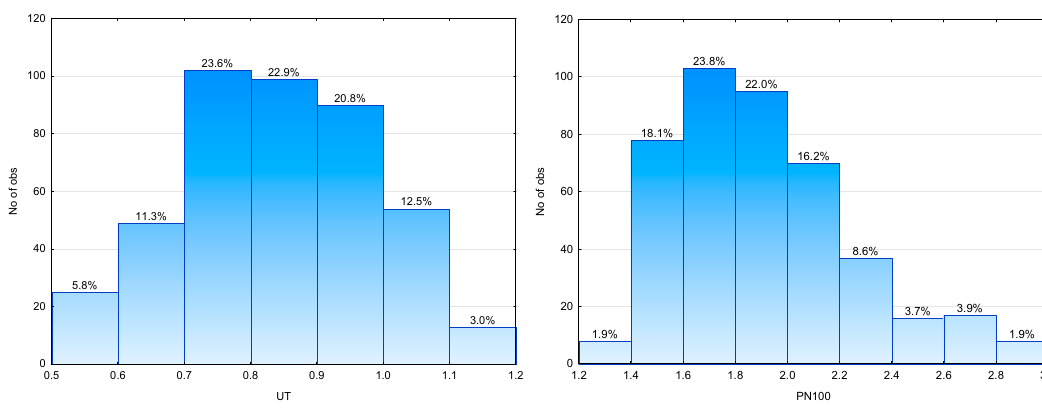
Figure 4. Histograms of EC / EN and EW / EN for the analyzed cases.